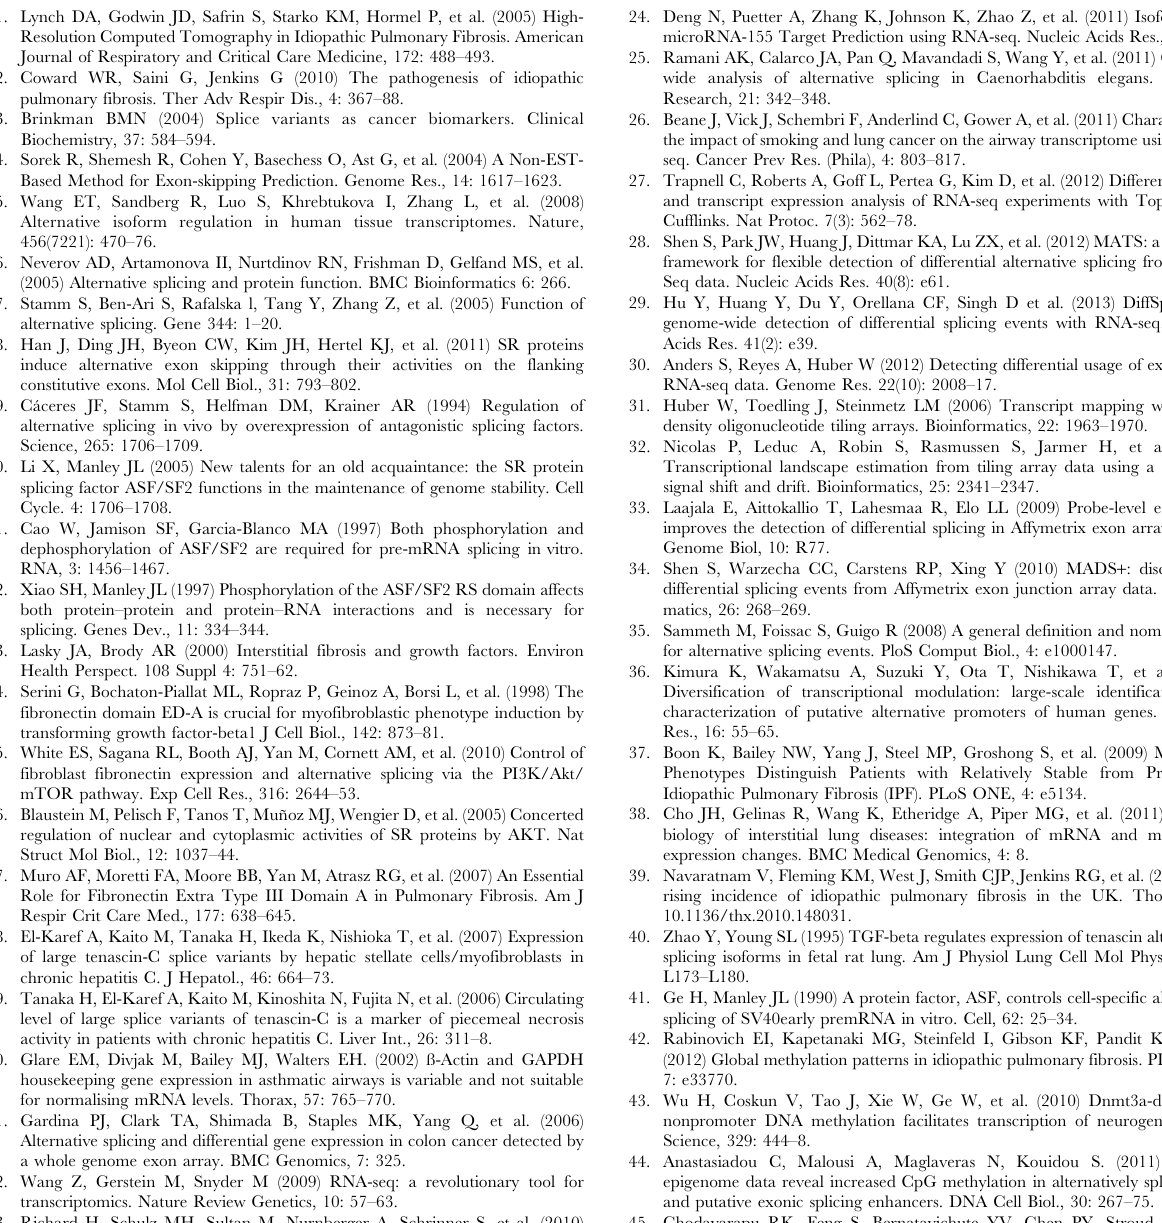
Table S6 Primers used in qRT-PCR validation